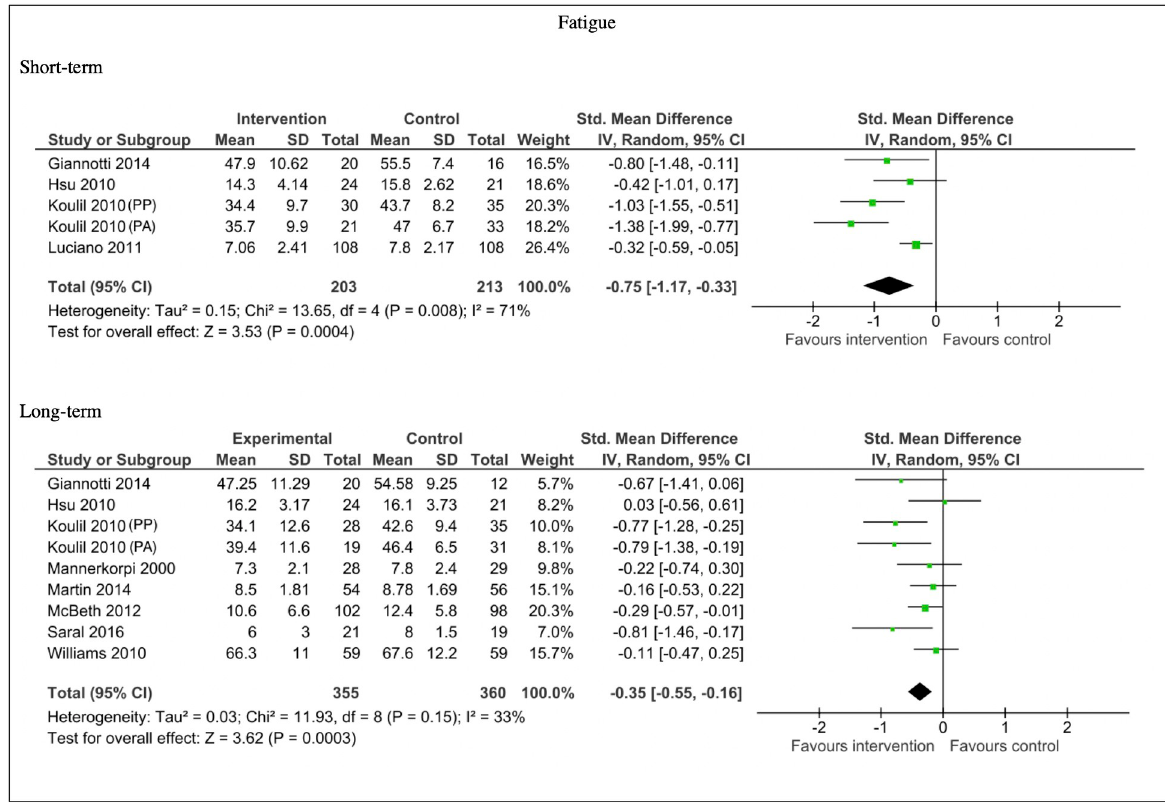
Fig 7. Forest plots of comparisons for fatigue measures for intervention compared to waitlist/no treatment/usual care controls.